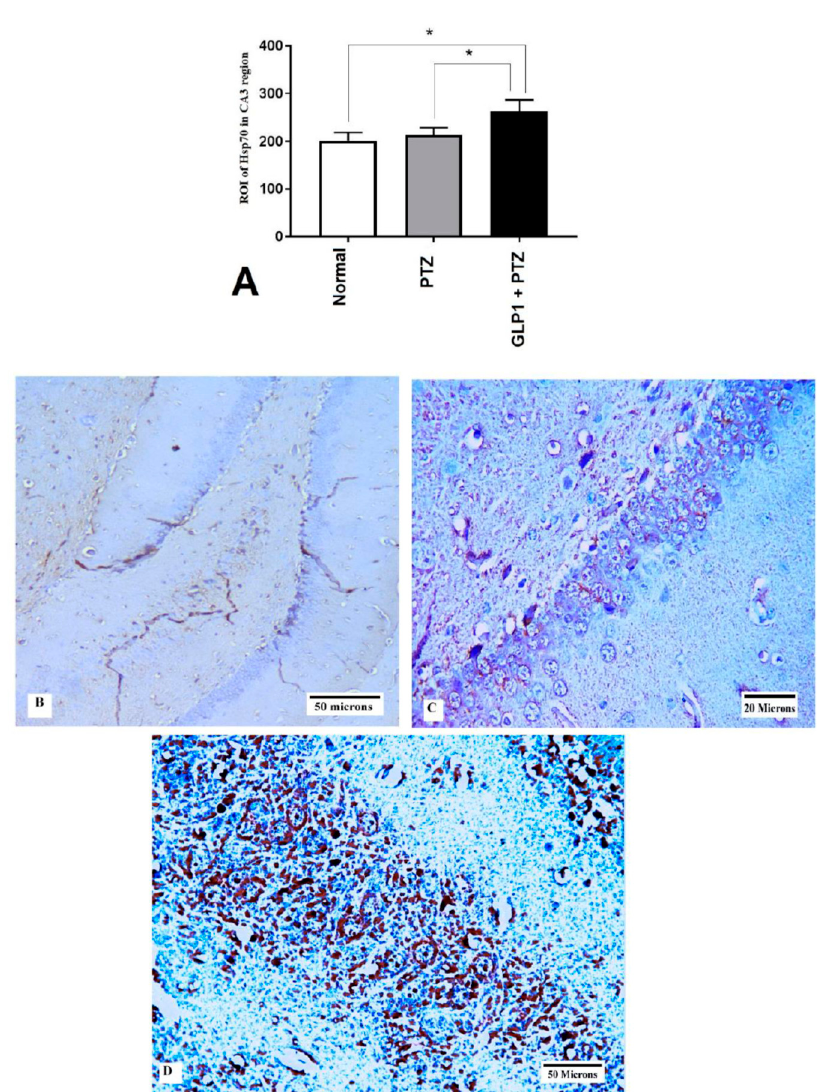
Figure 5. Effects of GLP1 on Hsp70 expression in CA3 hippocampal region. Score of Hsp70 expression in CA3 hippocampal region ( A ), brain sections shows negative expression of HSP70 in CA3 hippocampal region in normal group ( B ), brain sections showing mild HSP70 expression in CA3 hippocampal region in PTZ group ( C ) and brain sections showing marked HSP70 expression in CA3 hippocampal region in GLP1 + PTZ group ( D ). One ‐ way ANOVA with Tukey posthoc test. *, statistically significant difference between two groups.